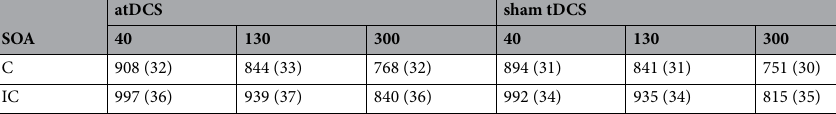
Table 3. RT2 (in ms) as a function of Stimulation condition (atDCS vs. sham tDCS), SOA (40 vs. 130 vs. 300 ms), Compatibility (compatible vs. incompatible). Standard errors of the mean are presented in